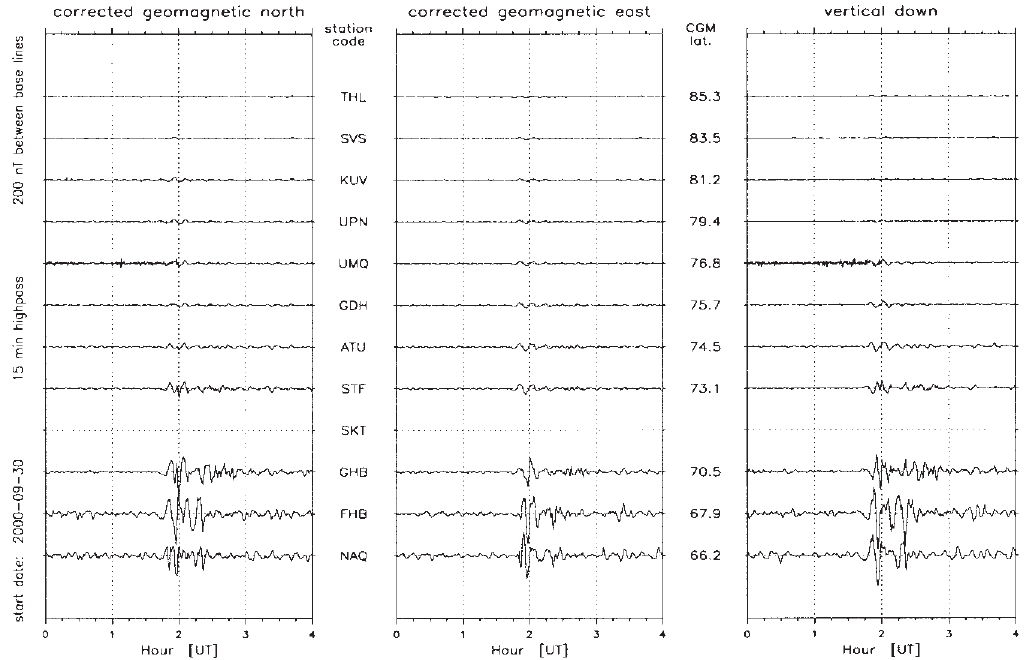
Fig. 5. Stacked high-pass filtered magnetic field variations along the Greenland west coast (15 min cutoff ), separated into geomagnetic north, east and vertical